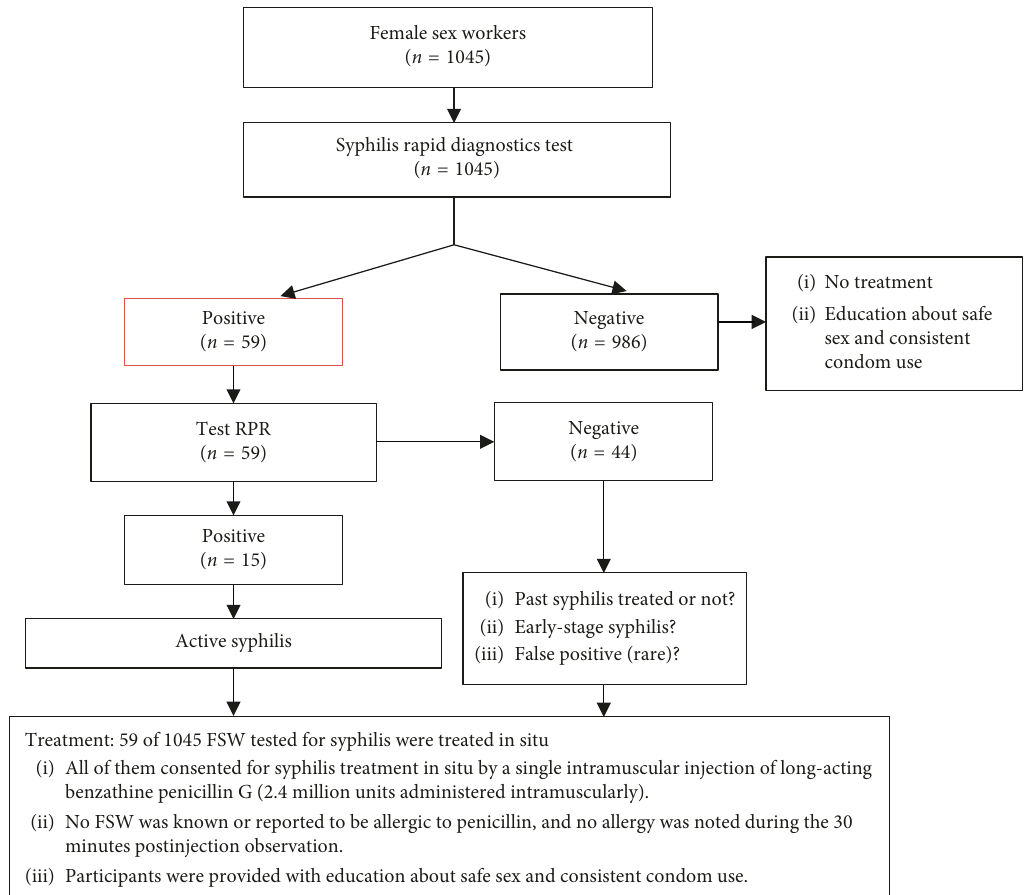
Figure 1: Flowchart of syphilis screening among study